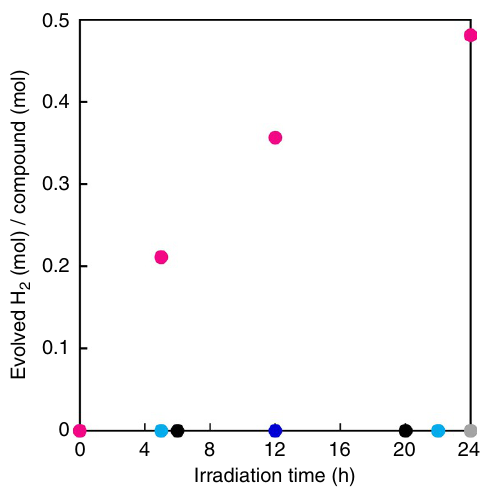
Figure 5 | H 2 evolution from a MeOH solution of 1. Mols of evolved H 2 per mol of catalyst as a function of PHER time for MeOH solutions of apH 2 (2mM; black circles), apH (cid:2) (2mM; turquoise circles), 1 (1mM; magenta (cid:3) circles) and Fe II (ClO 4 ) 2 6H 2 O (1mM; blue circles), together with pure MeOH (grey circles). Irradiation wavelength, 350 ± 10nm (21.8mW). Estimated relative s.d., 5%.